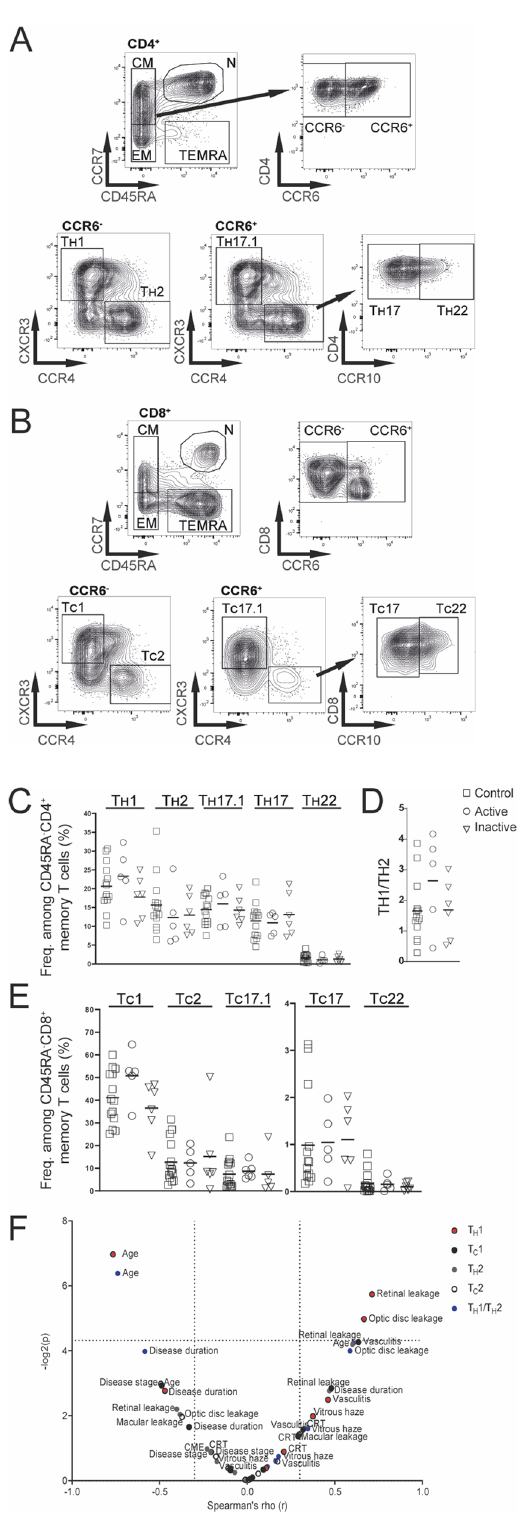
Figure 2. Inflammatory T-cell subsets in BSRC blood. ( A ) CD4 + and ( B ) CD8 + CD45RA − central and effector memory T cells were used to gate CCR6 + and CCR6 − fractions. CCR6 − cells were further distinguished in T1, based on CXCR3 expression or T2, based on CCR4 expression. CCR6 + cells were distinguished in T17.1, based on CXCR3 expression and T17 and T22 subsets were gated based on CCR4 and CCR10 expression. ( C ) Lines show median frequencies of CD4 + T H 1, T H 2, T H 17.1, T H 17 and T H 22 T-cell subsets of controls and active/inactive BSRC patients. ( D ) The frequencies of T H 1 and T H 2 fractions were used to calculate a T H 1/T H 2 ratio. ( E ) Lines show median frequencies of CD8 + T C 1, T C 2, T C 17.1, T C 17 and T C 22 T-cell subsets. ( F ) Volcanoplot (− log10) shows Spearman’s Rho correlation coefficient of immunological versus clinical parameters of T H 1, T H 2, T C 1, T C 2 T-cell populations and T H 1/T H 2 ratio of BSRC patients. BSRC birdshot retinochoroiditis, CM central memory, CME cystoid macula edema, CRT central retinal thickness, EM effector memory, N naïve, T C cytotoxic T cell, T H T-helper, TEMRA terminally differentiated effector memory CD45RA +